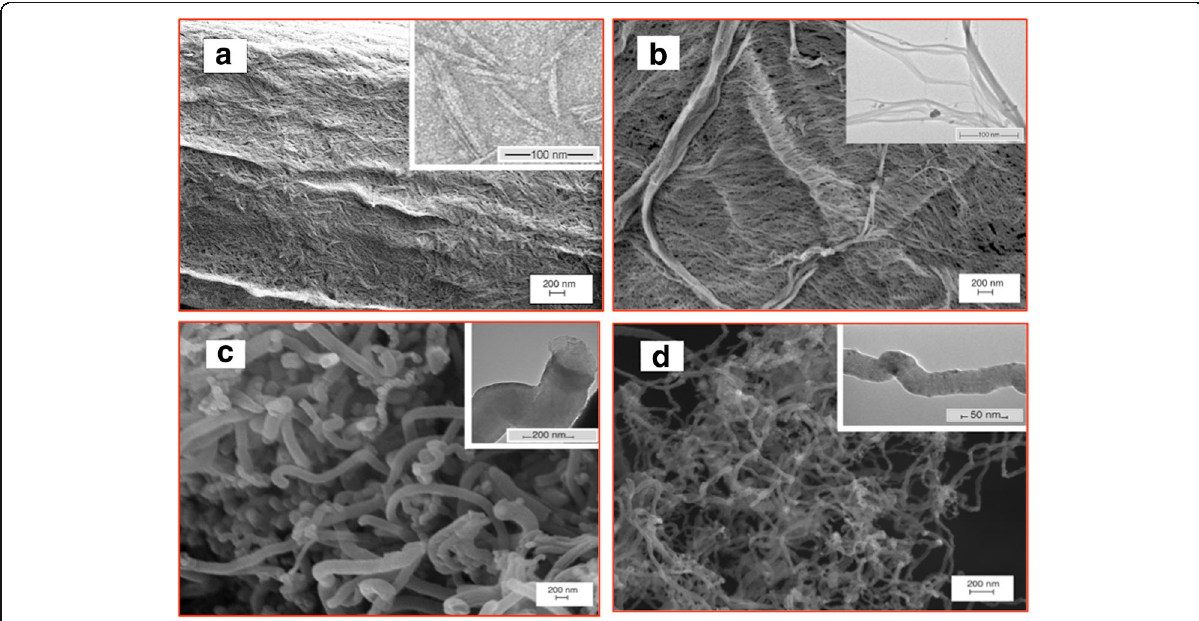
Fig. 1 SEM/TEM images of a CNC, b NFC, c CNF, and d